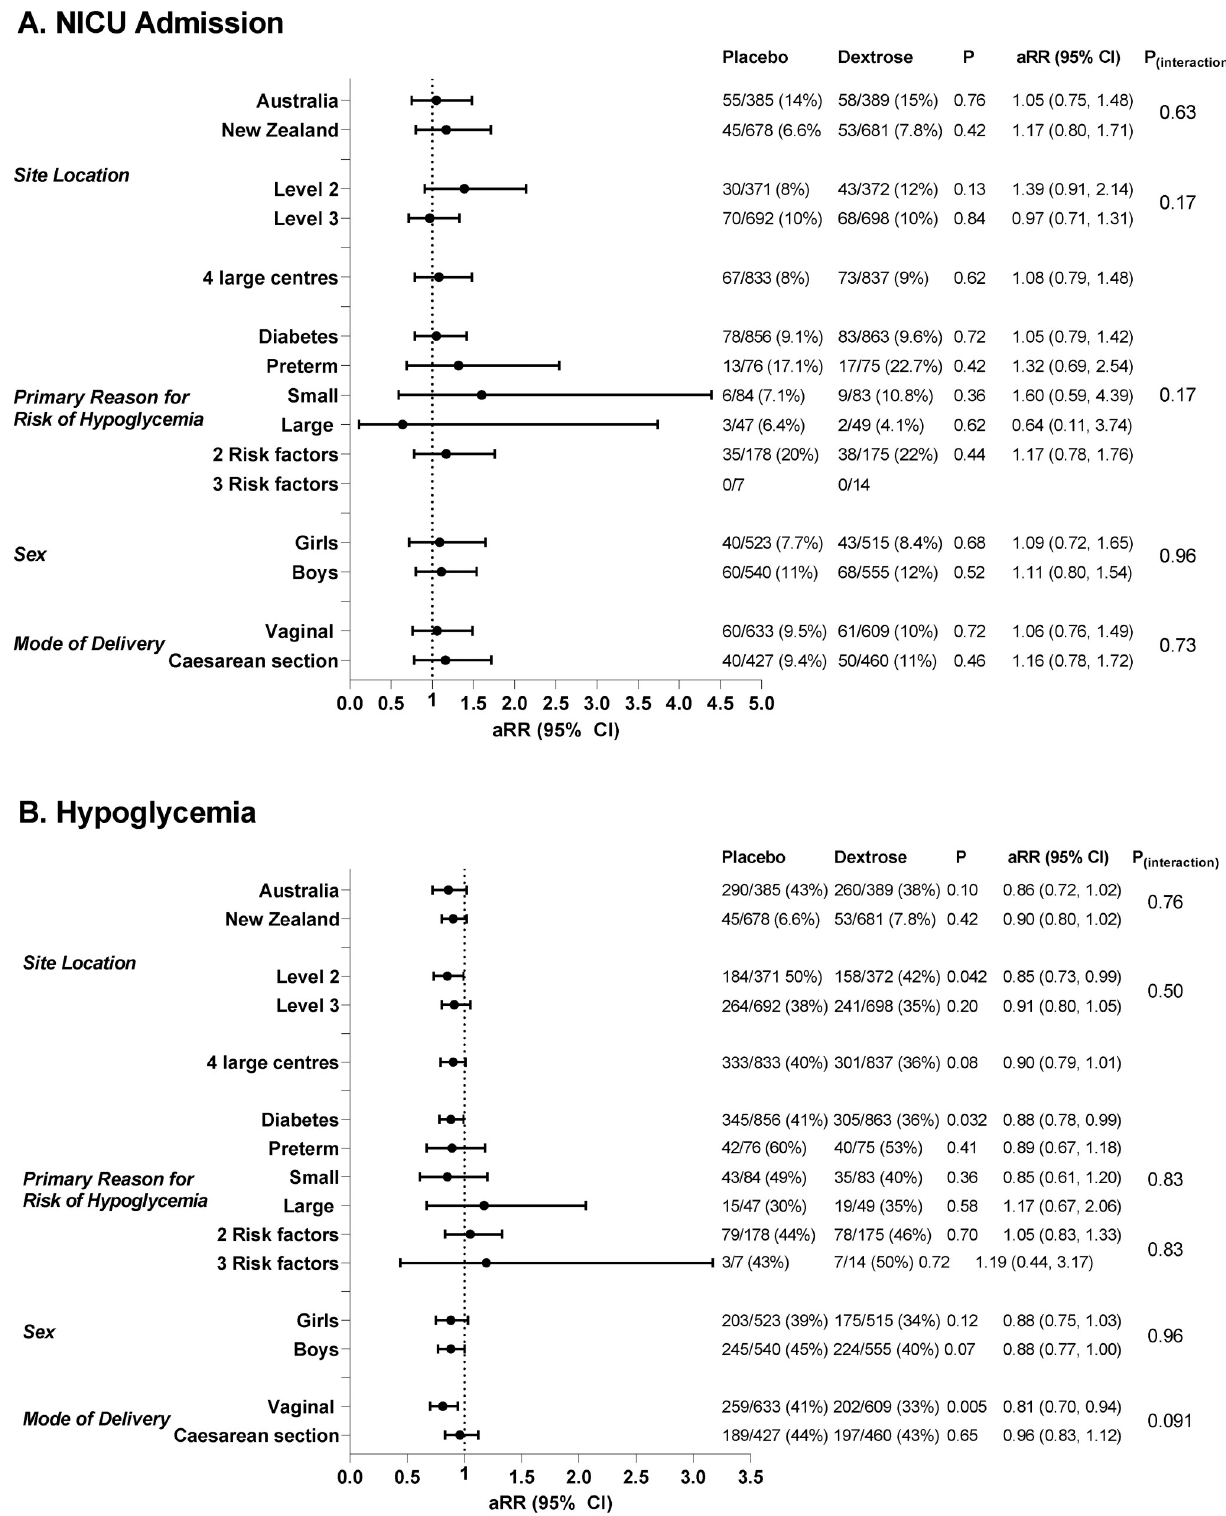
PLOS Medicine| https://doi.org/10.1371/journal.pmed.1003411 January 28, 2021 10 /